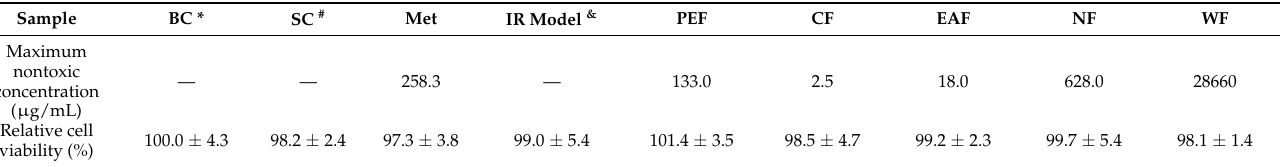
Table 4. Relative cell viability of different extracted fractions at their maximum nontoxic concentration.